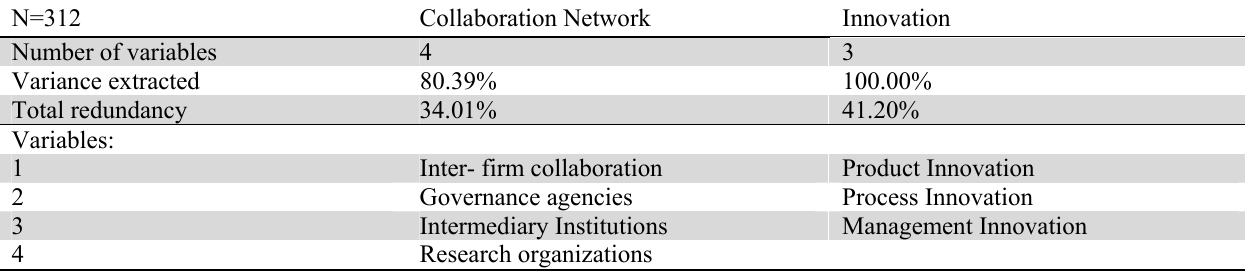
Canonical correlation analysis summary